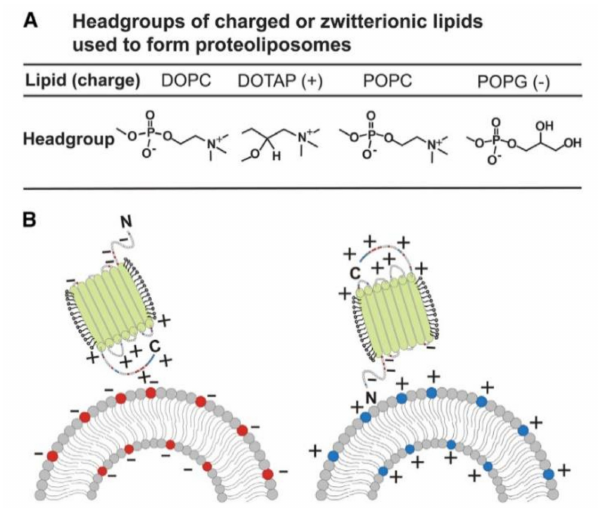
Figure 9. Directionality of the insertion of proteorhodopsin (PR) into liposomes. ( A ) Different lipids, which have positively charged, negatively charged or zwitterionic headgroups, were